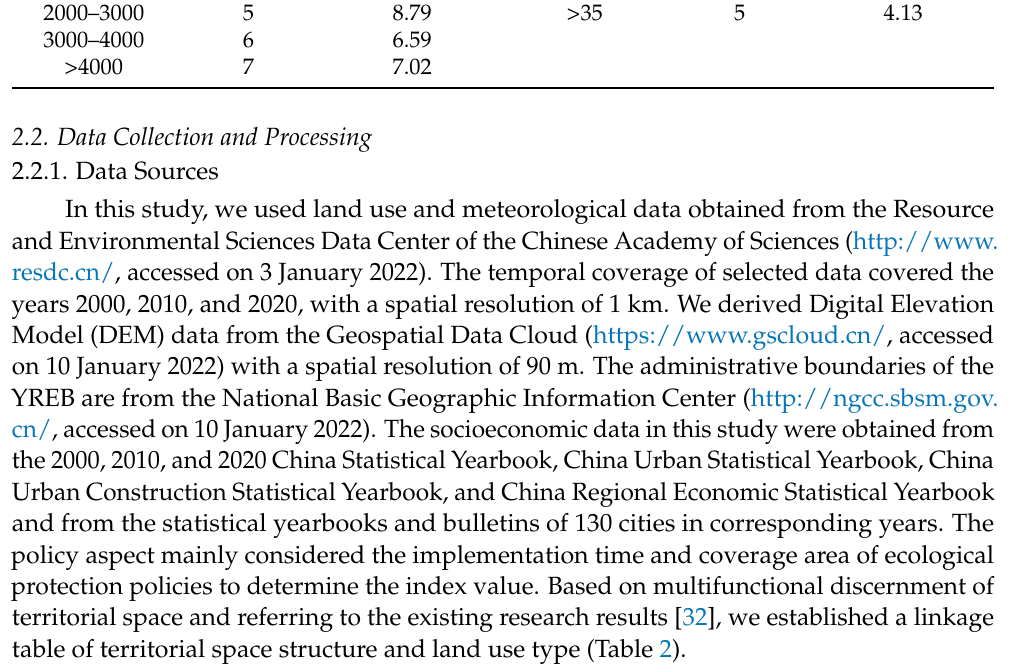
Table 2. Connection between classification of territorial space and classification of land use in the Yangtze River Economic